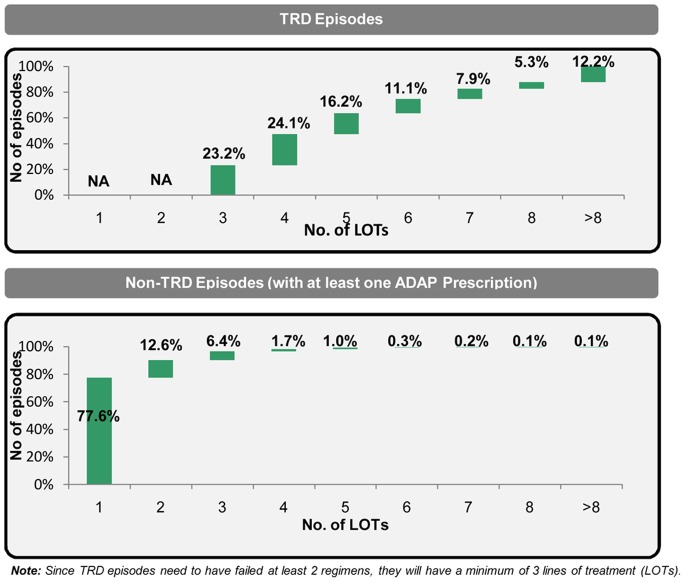
Distribution of episodes based on lines of therapy.Distribution of episodes by number of lines of treatment contained therein, compared for TRD and non-TRD episodes.